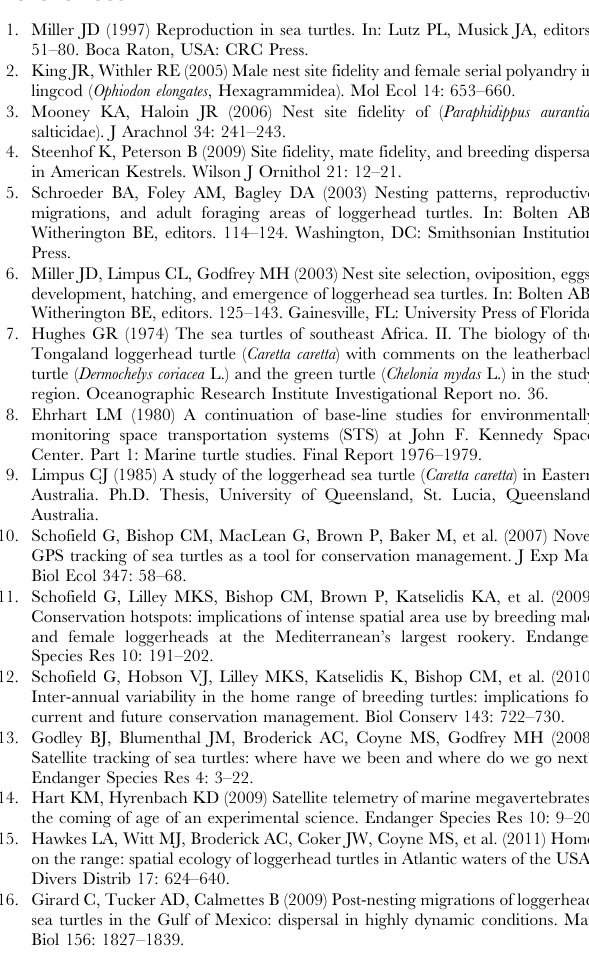
Table S1 Observed emergence location distances for Northern Gulf loggerhead turtles ( Caretta caretta ). Table S2 Examples of posterior of switching state space model parameters for two satellite-tracked loggerhead turtles. Table S3 Northern Gulf loggerhead turtles ( Caretta caretta ) with potential inter-nesting kernel density estimates (KDEs) that failed site-fidelity tests. Table S4 Minimum convex polygon (MCP) areas for loggerhead turtle ( Caretta caretta ) inter-nesting periods with and without kernel density estimates (KDEs), with depths and distances to shore from MCP centroids. Table S5 Depths for filtered locations of satellite-tracked adult nesting loggerheads ( Caretta caretta ) in the Northern Gulf of Mexico, 2010–2012. Table S6 Shrimp trawling (data provided by NOAA) and oil and gas platform threats (from www.data.boem.gov) at or near loggerhead ( Caretta caretta ) inter-nesting minimum convex polygon (MCP) and kernel density estimate (KDE)